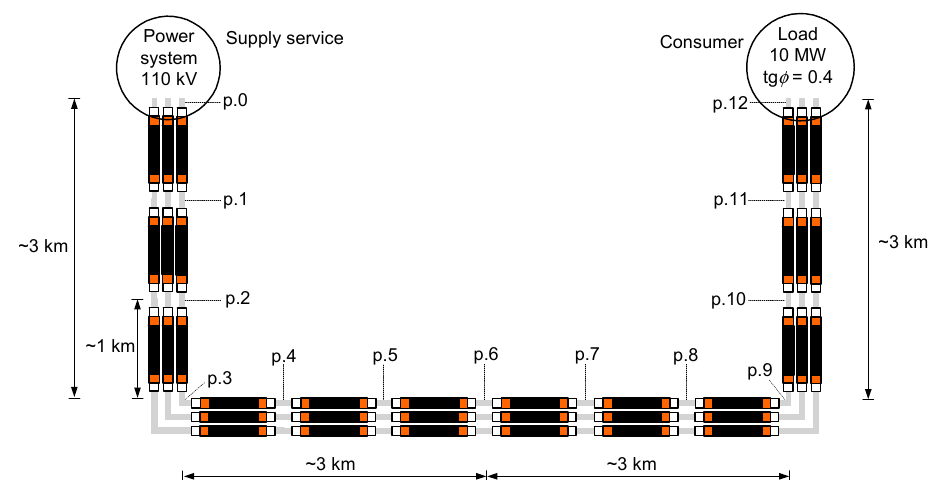
Figure 2. General data of the analyzed power cable system; p.0–p.12—possible points for earthing and bonding.